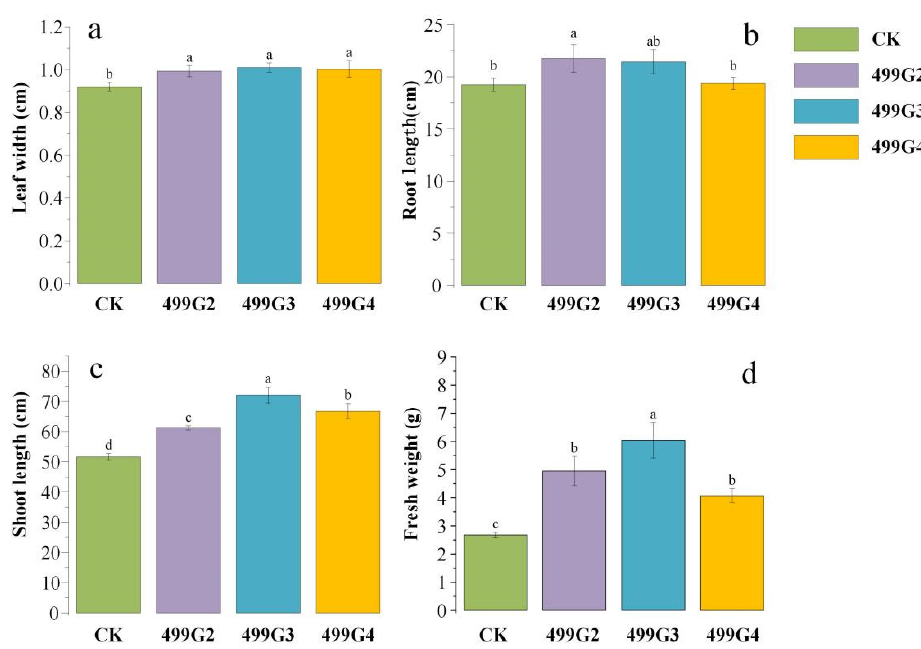
Figure 3. Effects of 499G2, 499G3 and 499G4 on leaf width ( a ), root length ( b ), shoot ( c ) and fresh weight ( d ) of rice. Error bars represent standard errors ( n = 3). Different lowercase letters show statistically significant difference ( p value < 0.05).